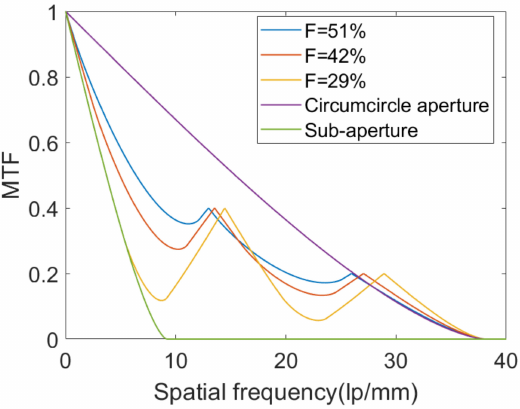
Figure 9. The MTFs corresponding to filling factors are 51%, 42% and 29%, respectively.